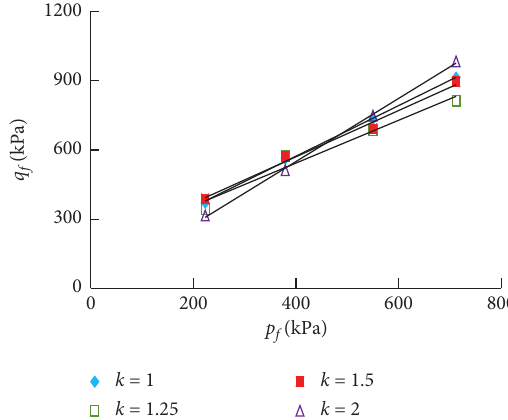
Figure 16: Change law between q